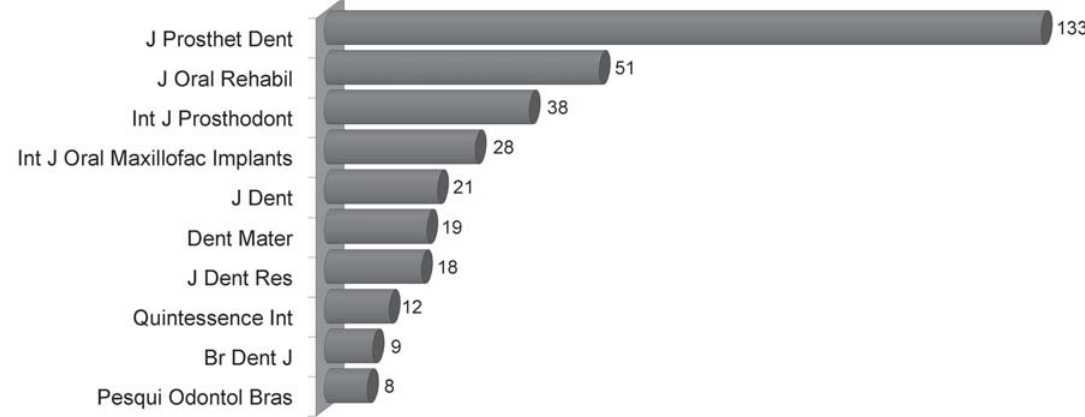
FIGURE 6- Journals of the area of Prosthodontics most frequently cited in the JAOS between 2005 and